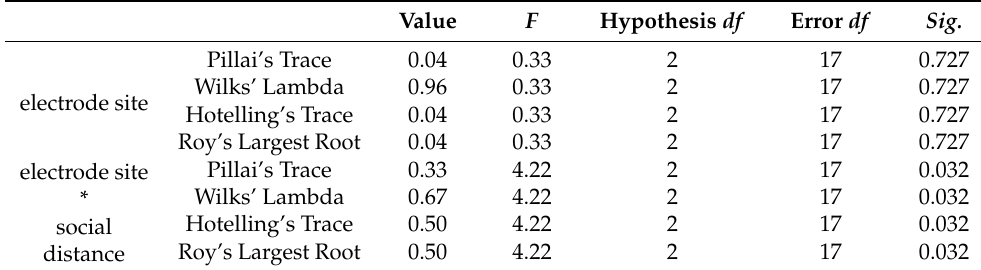
Table 12. Multivariate tests of P2 amplitude (promotion focus).